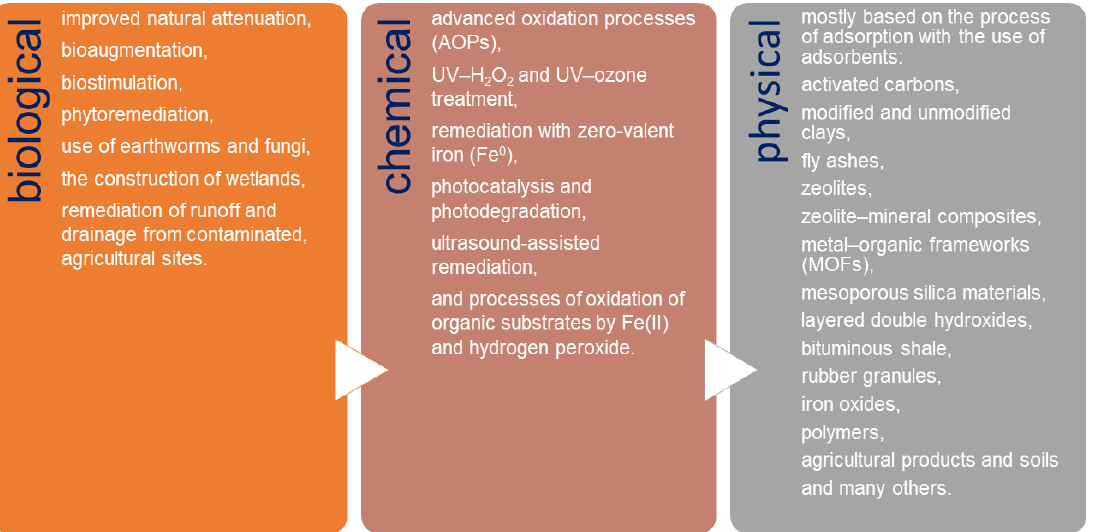
Figure 1. Methods used for pesticide remediation.